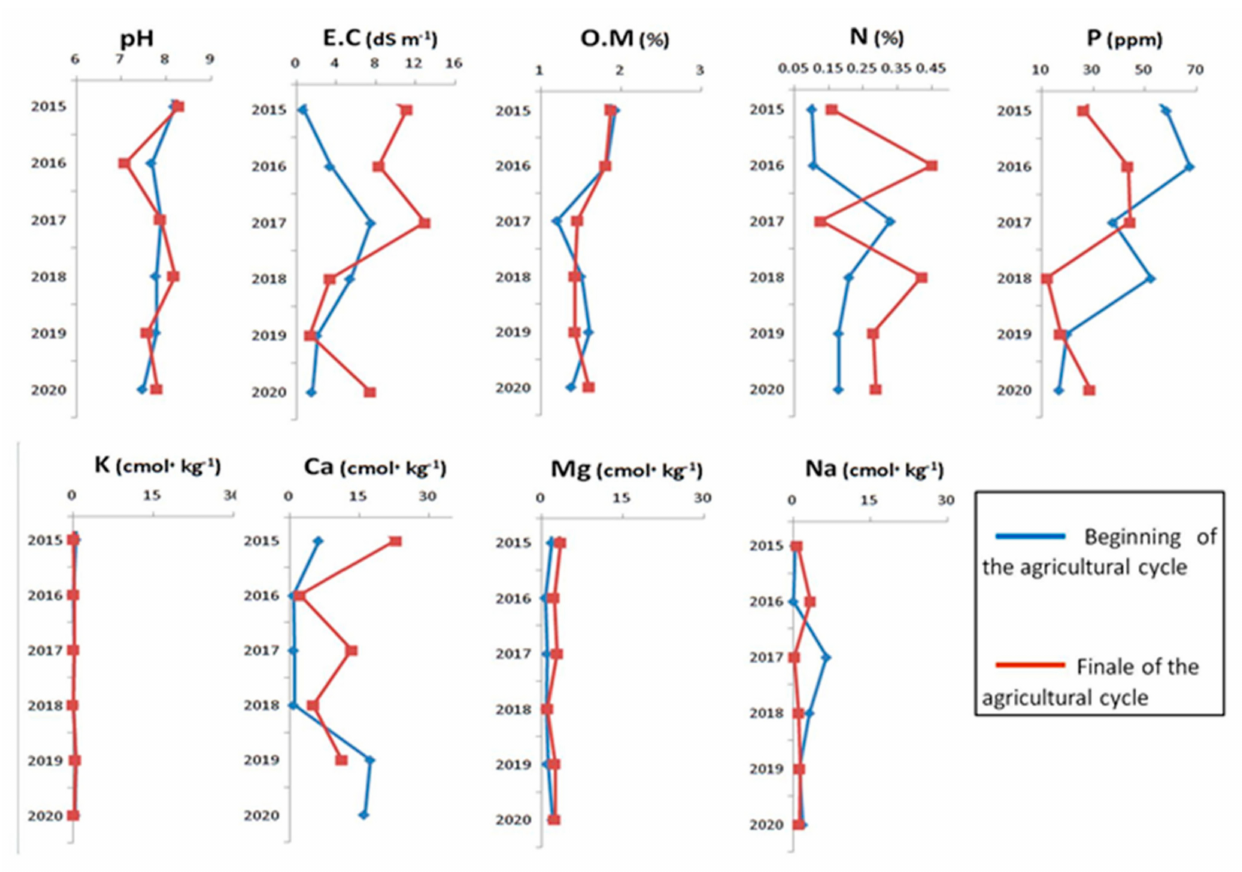
Figure 8. Annual variability of chemical characteristics of agricultural soil (0–30